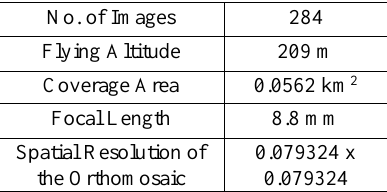
Table 2: Details of the first UAV flight